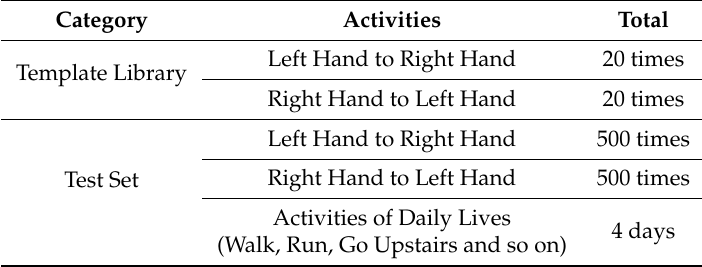
Table 8. Experimental dataset for recognizing the hand-changing process employing DTW. Category